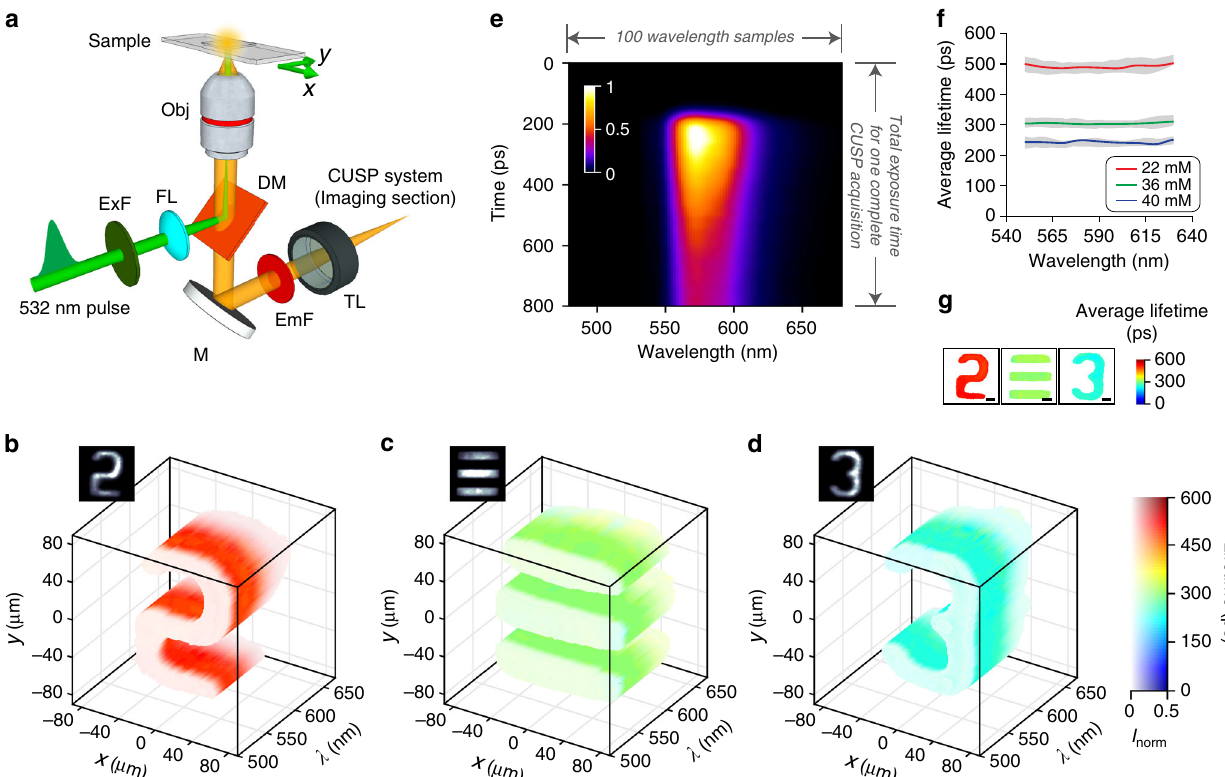
Fig. 4 CUSP-based 4D SR-FLIM. a Schematic of the fl uorescence microscopy setup, connected with the passive CUSP system. DM, dichroic mirror; EmF, emission fi lter; ExF, excitation fi lter; FL, focusing lens; M, mirror; Obj, microscope objective; TL; tube lens. b – d Reconstructed lifetime distributions over the spatial (2D) and the spectral (1D) domains for three samples of different patterns and Rh6G concentrations: b 22 mM, c 36 mM, and d 40 mM. The entire spatial-spectral evolutions are in Supplementary Movie 4. Insets: temporally and spectrally integrated light intensity distributions in the x – y plane. e Spatially integrated light intensity distribution in the t – λ space for the sample of 22 mM in ( b ). This 2D distribution is normalized to its maximum. f Reconstructed average lifetimes at different wavelengths. The gray bands represent the standard deviations of lifetimes in the spatial domain. g Spectrally averaged lifetime distributions in the x – y plane for the three samples. Scale bars: 30 μ